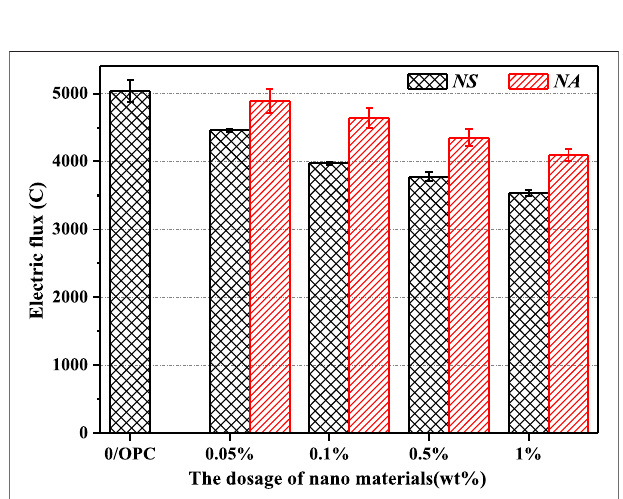
FIGURE5| Theeffectofdosageontheelectric fl uxofthenano-modi fi ed concrete.